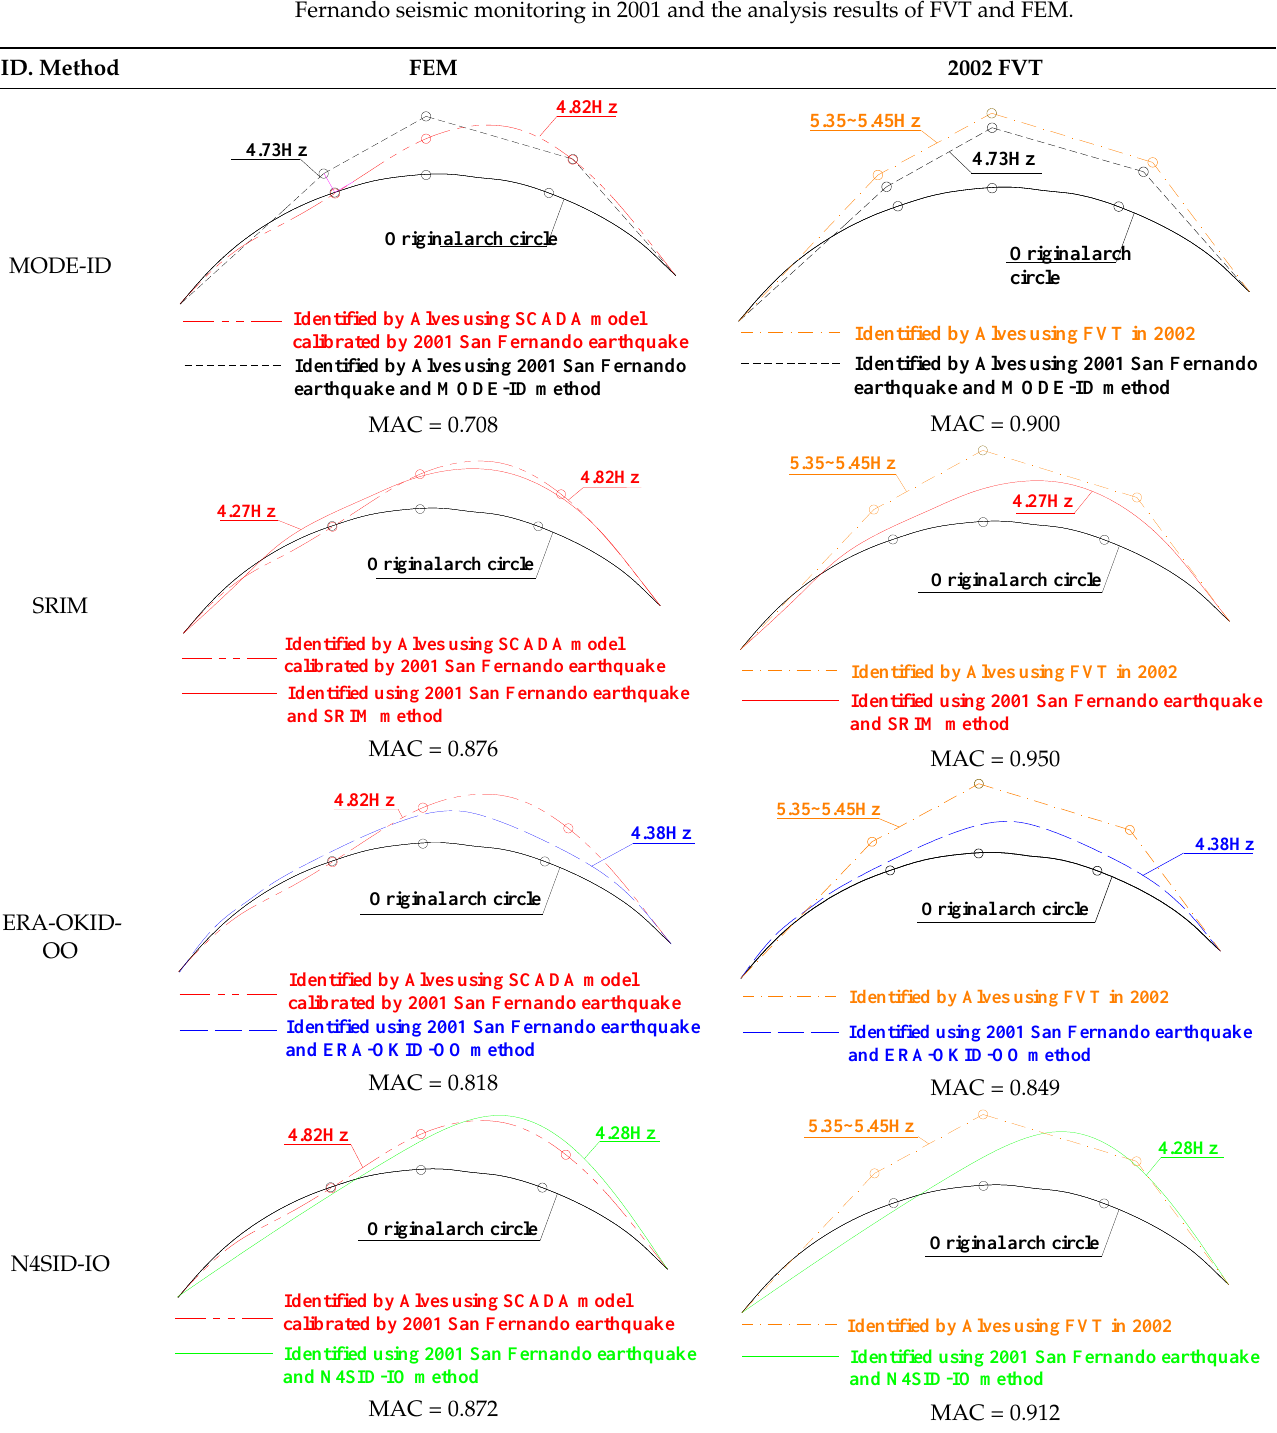
Table 8. Comparison between the identified first-order symmetric vibration modes based on San Fernando seismic monitoring in 2001 and the analysis results of FVT and FEM.